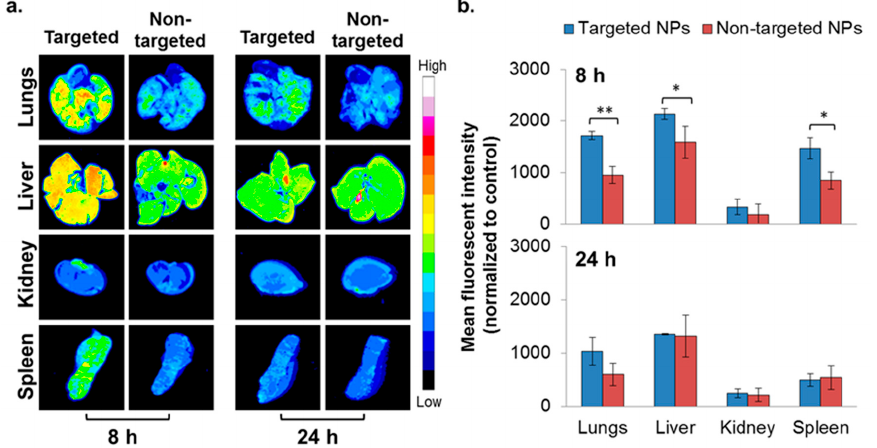
Figure 4. Biodistribution of NPs in the 4T1 intravenous (IV) model. Typhoon images ( a ) followed by ImageJ analysis ( b ) demonstrating targeted ( n = 3) and non-targeted ( n = 3) NPs accumulation in different organs. (Non-targeted NPs are described in [22].) The mean fluorescent intensity in each organ was normalized to untreated control. Data is presented as mean ± SD, * p < 0.05, and ** p < 0.001.